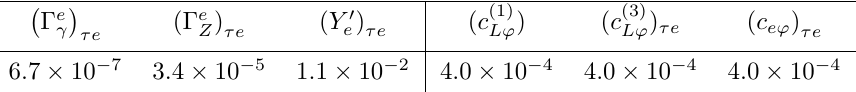
Table 11 . 90% C.L. upper limits on lepton bilinear operators, assuming a single operator is turned on at the scale Λ = 1 TeV. The bounds on the the dipole and Yukawa operators are dominated by τ → eγ , while those on the Z couplings c (1 , 3)